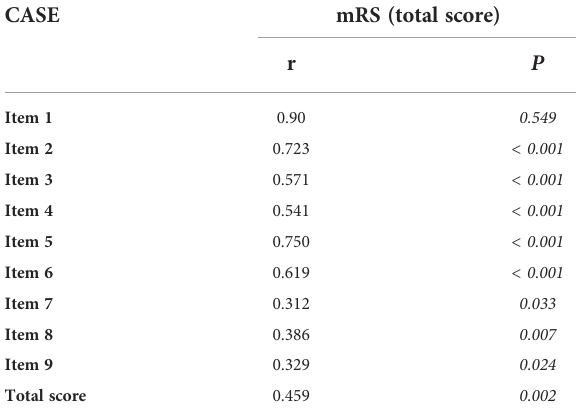
TABLE 2 Pearson correlation analyses of CASE scores and mRS total